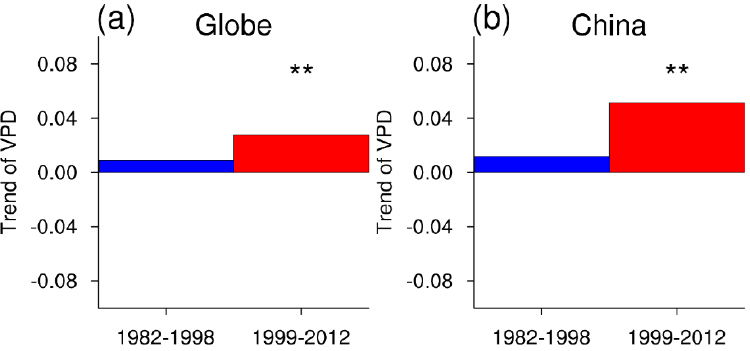
Figure 5. ( a ) Trends of atmospheric vapor pressure deficit (VPD) (unit: hPa yr −1 ) for ( a ) the globe and ( b ) China. Two asterisks indicate that the trend is statistically significant ( p < 0.05).